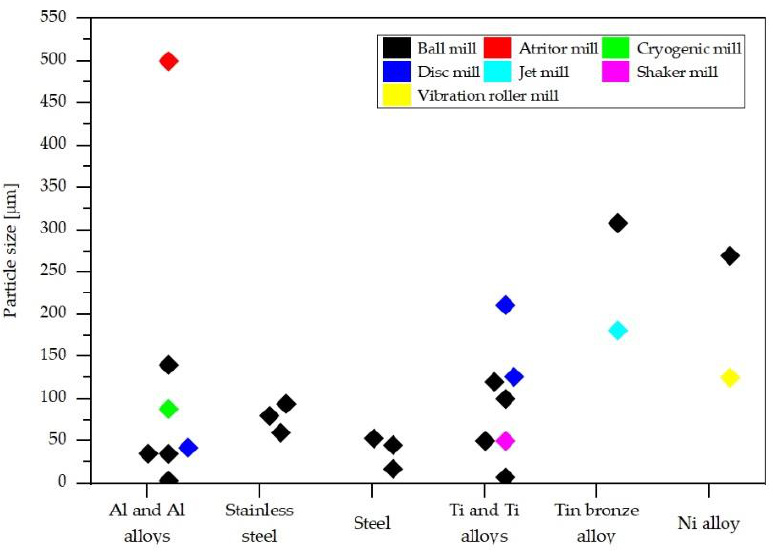
Figure 1. Illustration of particle size mentioned in Table 1.